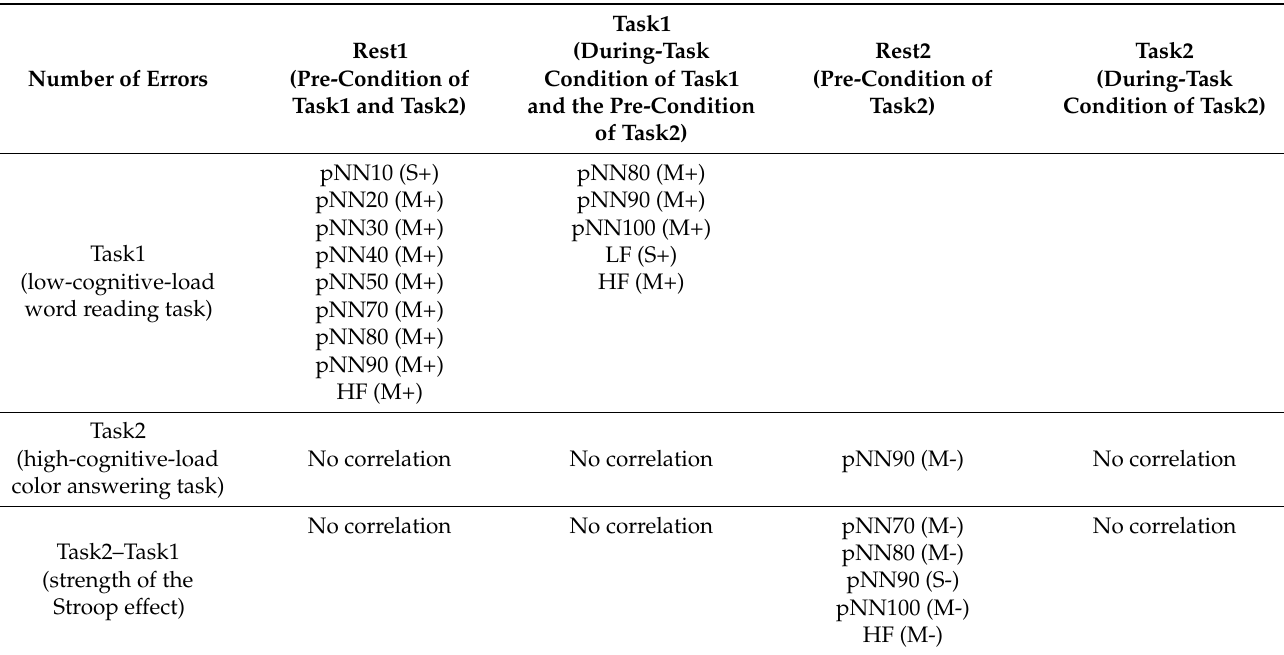
Table 16. Correlation analysis results of HRV indexes (“M+”: moderate positive correlation; “S+”: strong positive correlation; “M-”: moderate negative correlation; “S-”: strong negative correlation).